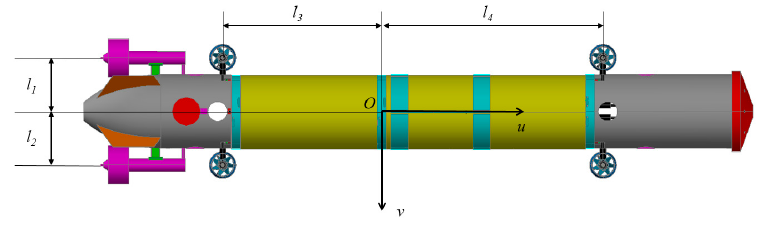
Figure 11. Layout of the AUV thrusters.